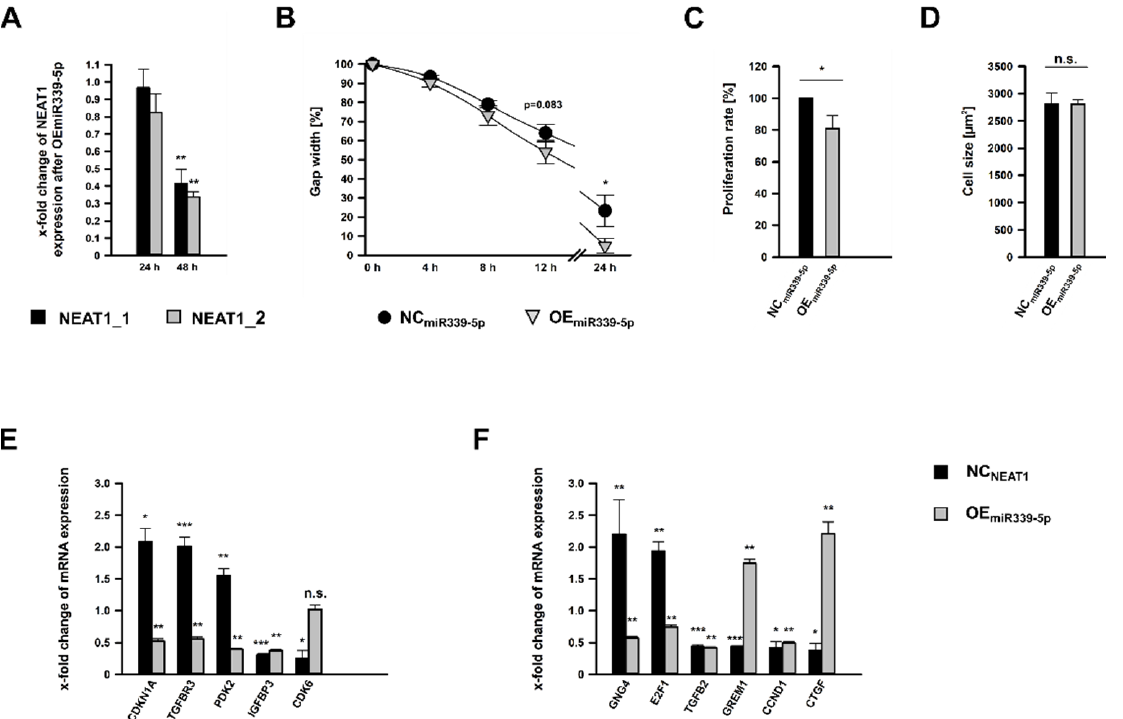
Figure 6. Effects of miR-399-5p overexpression (OE miR339-5p ) on human mesangial cells (hMCs) using miR-339-5p mimics. ( A ) Reduced expression of NEAT1_1/2 after OE miR339-5p was detected after 24 or 48 h, shown as x-fold changes + SD for NEAT1_1 (black bars + SD) and NEAT1_2 (grey bars + SD), normalized to the expression after treatment with negative control RNA (NC miR339-5p ); n = 4. ( B ) Cell migration was analyzed by wound healing assay by measuring the gap width, directly after removing the cell culture insert (0 h) and 4 h, 8 h, 12 h, and 24 h later. Black circles ± SD or grey triangles ± SD represent hMCs subjected to NC miR339-5p and OE miR339-5p , respectively; n = 4. ( C ) Proliferation rate of hMCs after OE miR339-5p (grey bar + SD) compared to NC miR339-5p treated cells (black bar + SD). Proliferation was ascertained by a BrdU assay; n = 4. ( D ) Cell size in µ m 2 of hMCs after OE miR339-5p (grey bar + SD) compared to NC miR339-5p treated cells (black bar+ SD). Cell size measurement